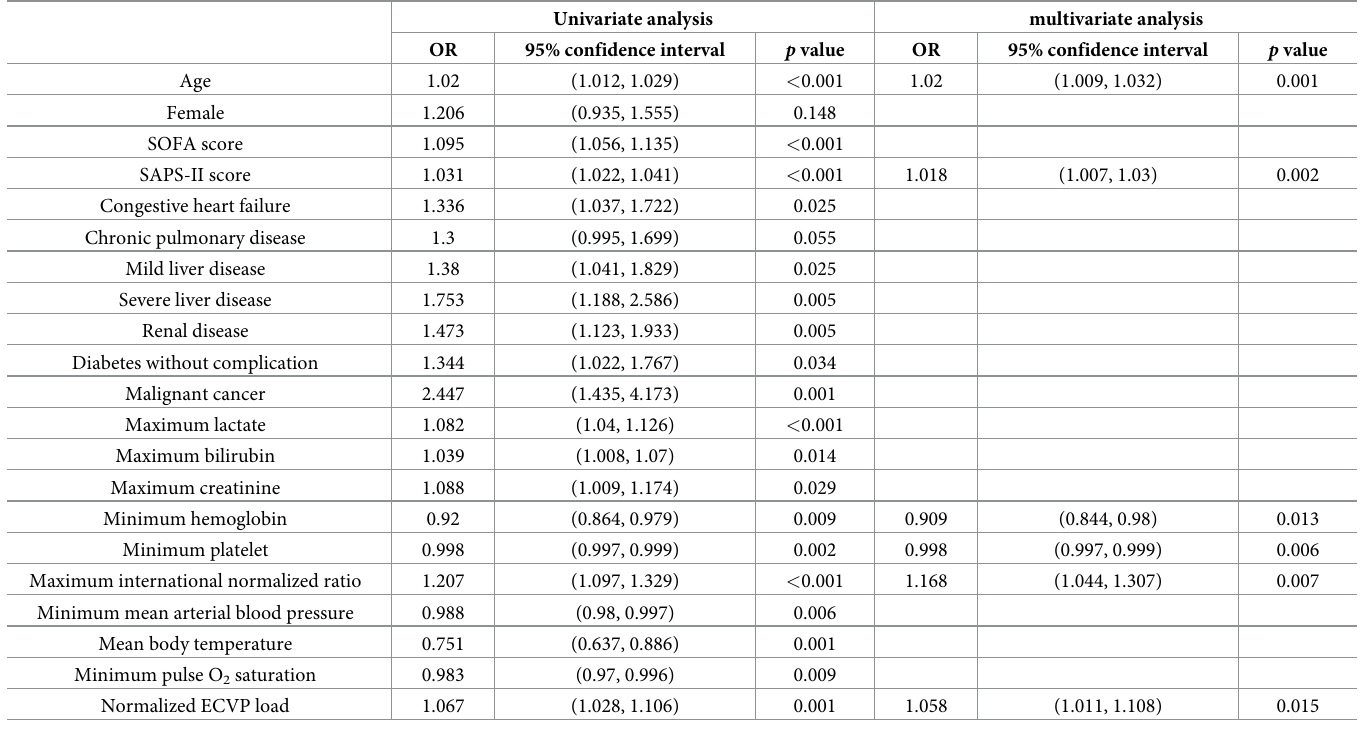
Table 3. Risk factors identified by univariate and multivariate logistic